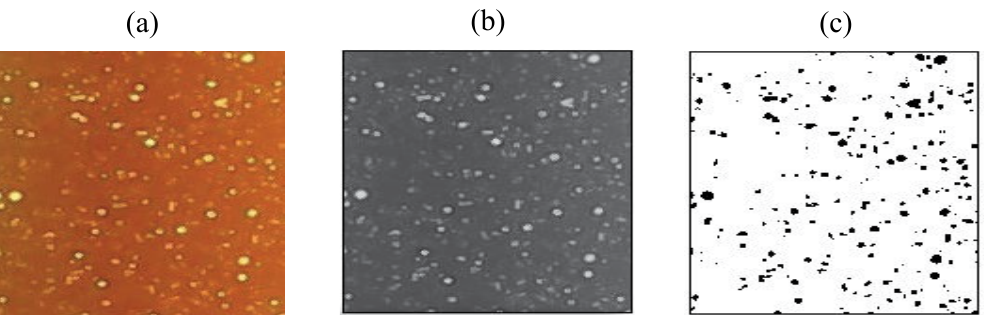
Fig. 5: The procedure of analyzing the emulsion by the ImageJ software: (a) input raw picture, (b) converted 8-bit picture, and (c) ultimate analyzed picture.